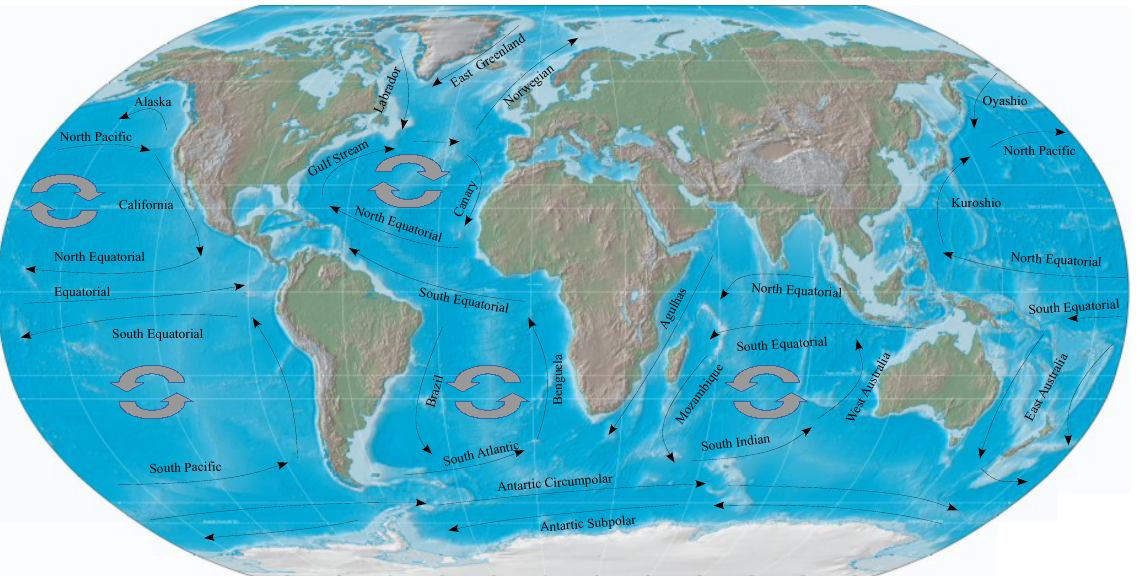
Figure 3. A map of the circulation of the world’s